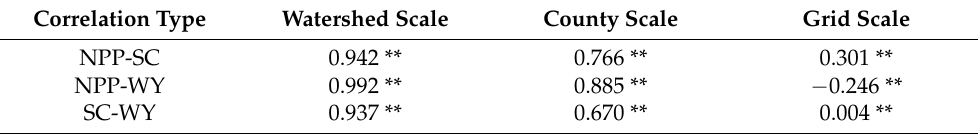
Table 2. Correlation Coefficient Between Three Ecosystem Services in Jiangxi Province. Correlation